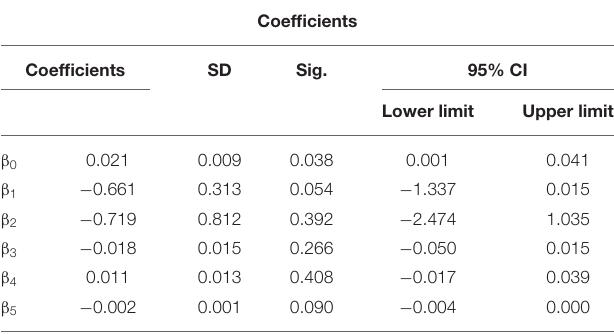
TABLE 1 | Results of the regression analysis for the period